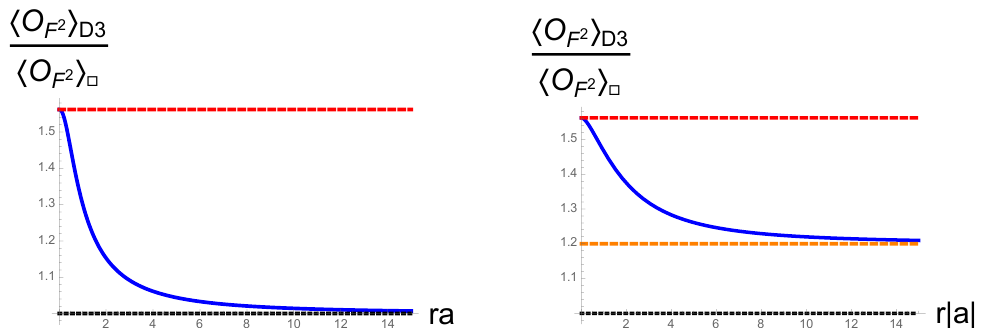
Figure 10 . The strength of hO i sourced by the D3-brane impurity for a > 0 (left) and a < 0 F 2 (right) with ~ (cid:20) = 1 : 2. For a > 0 it interpolates between the value for the symmetric representation S k (dashed red) and k fundamental quarks (dashed black). When a < 0, the large r value of the ratio hO i D3 = hO i (cid:3) = ~ (cid:20) (dashed orange), which can be bigger or smaller than F 2 F 2